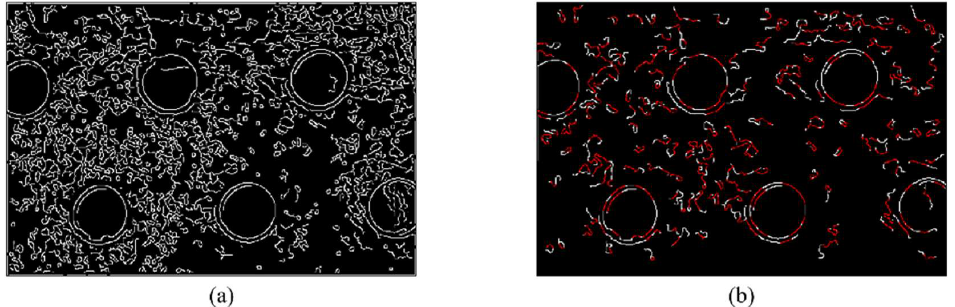
Figure 2. Intermediate results obtained by the algorithm: ( a ) the result of adaptive canny edge extraction, ( b ) the image after sharpness estimation. The recorded arcs are marked in red.